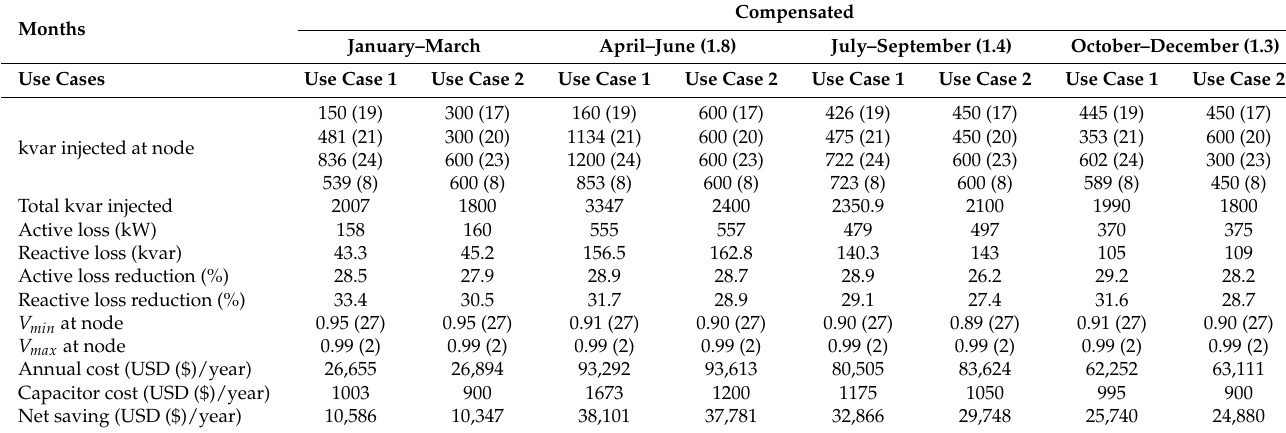
Table 7. Results comparison of N 1 for CS 2 (Scenario 2).